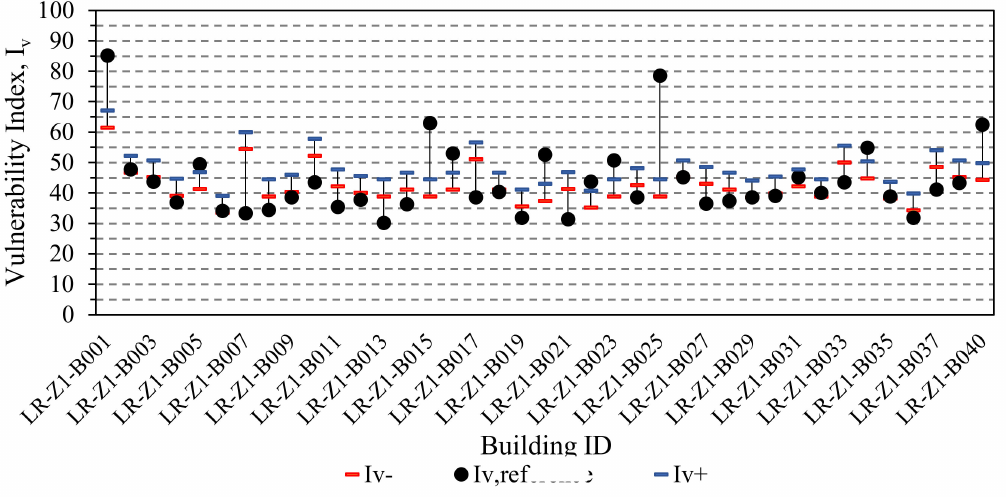
Figure 16. Comparison between the reference vulnerability index and the computed range.